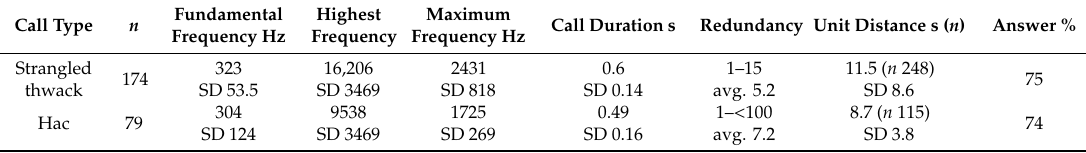
Figure 5. Comparison of Dendrohyrax strangled thwack and hac. The dots indicate maximum frequencies. Strangled thwacks have a higher frequency range (average 15,900 Hz) than Hac calls (average 9200 Hz). Hac is typically used in the beginning of the calling bout, or after a sequence of strangled thwacks. Duration of strangled thwack is slightly longer (average 0.6 s) than hac (average 0.5 s). Duration of the hac call is related to the number of subunits in the call. Table 2. Vocal characteristics of Taita Hills Dendrohyrax